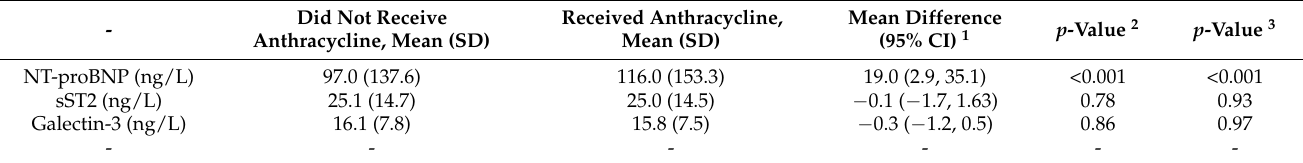
Table 2. Comparison of serum-derived cardiac biomarkers with receipt of anthracycline.